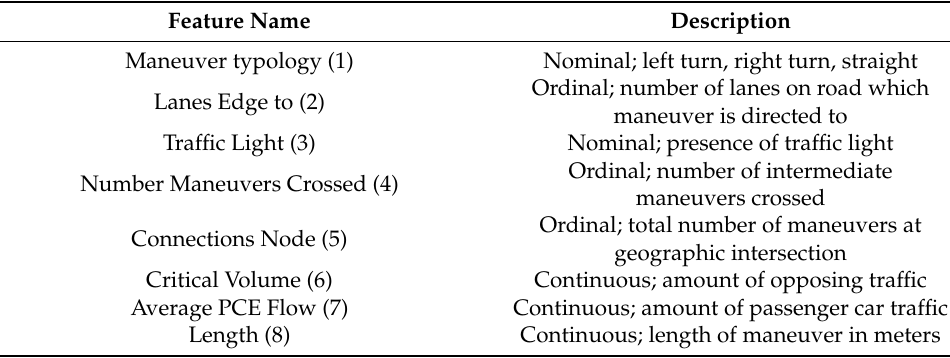
Figure 2. Histogram of the feature ‘number maneuver crossed’. Table 3. Selected feature